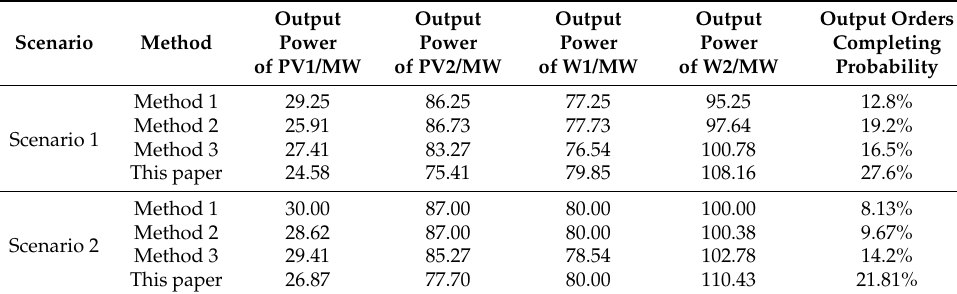
Table 5. Comparison of margin allocation methods in response to new dispatch